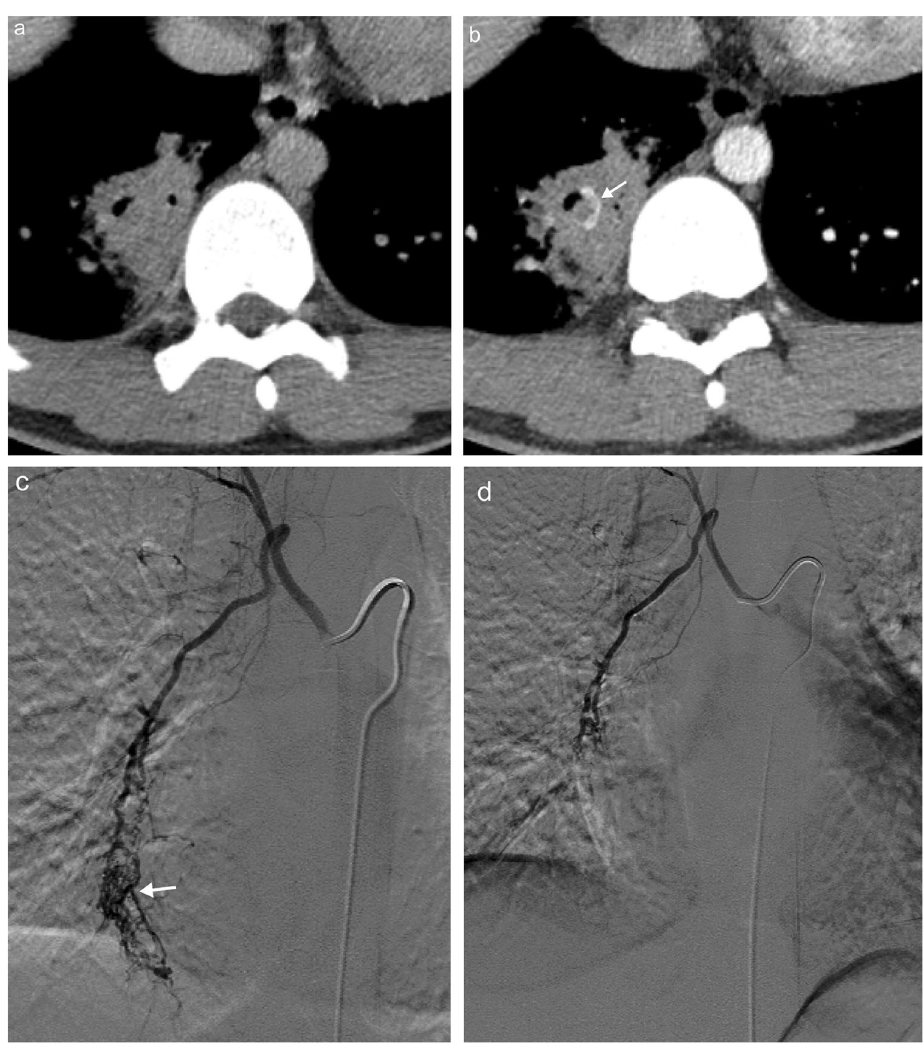
Fig. 21 Bronchial artery bleeding. Pre- ( a ) and post- contrast ( b ) axial images in a pa- tient with pneumonia and new onset haemoptysis demonstrates a blush of contrast within the right lower lobe consolidation concerning for active bleeding ( arrow ). Bronchial arteriogram demonstrates a blush of contrast ( arrow ) confirming bleed pre embolisation ( c ) with resolution of the contrast blush post emboli- sation ( d